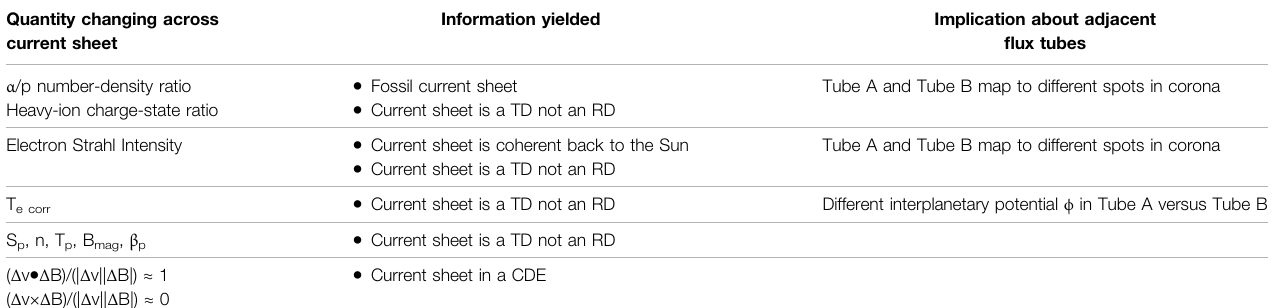
TABLE1| Informationthatisobtainedbyobservingajumpinaspeci fi cquantitywhencrossingacurrentsheetfrom fl uxtubeAinto fl uxtubeB.(TD=tangentialdiscontinuity and RD = rotational